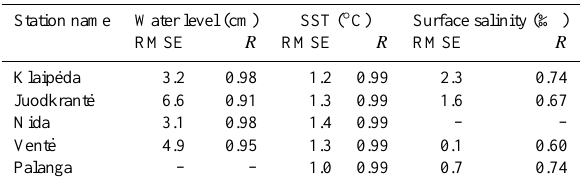
Table 1. Model performance statistics for water level, sea surface temperature (SST) and surface salinity inside of Klaip˙eda Strait (Klaip˙eda station), inside of the Curonian Lagoon (Juodkrant˙e, Nida, Vent˙e stations) and in the Baltic Sea (Palanga station). See Fig. 1 for the location of the stations. Analysis results are given in terms of root-mean-square error (RMSE) and correlation coefficient between observations and model results ( R